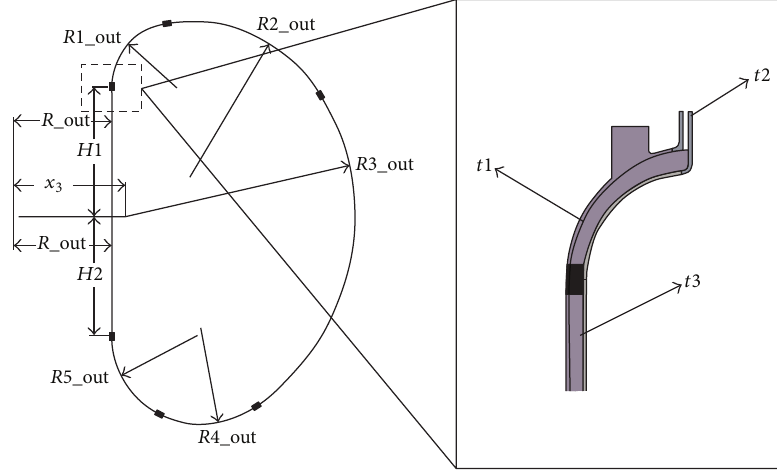
Figure 6: Main geometric parameters of VV.